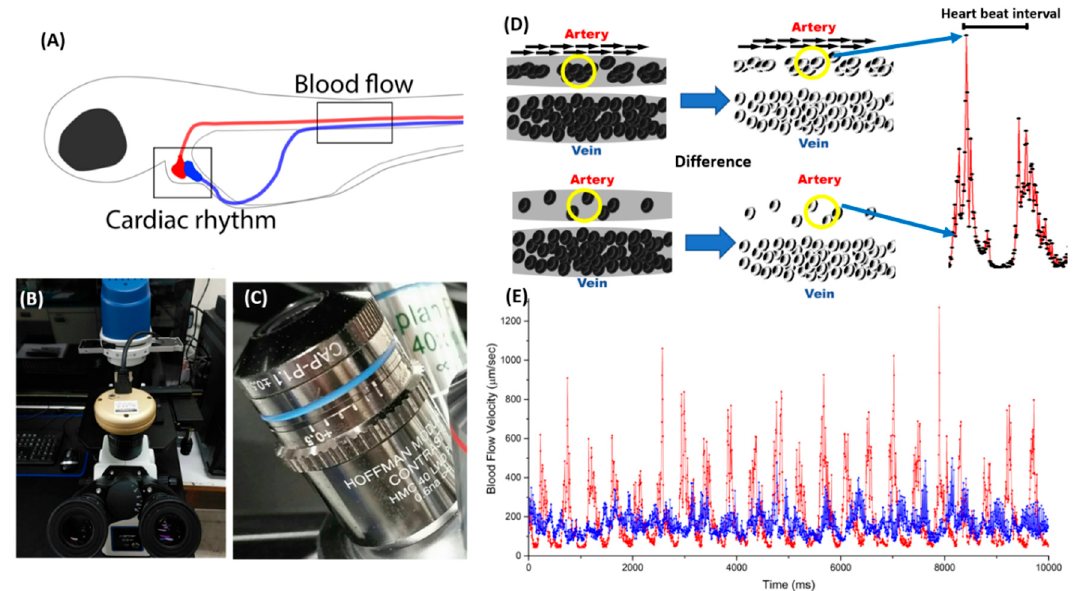
Figure 2. The instrumental framework for blood flow measurement in zebrafish embryos. ( A ) The area to detect heartbeat and blood flow is highlighted in black. ( B ) The inverted microscope, high-speed CCD and ( C ) Hoffman objective lens was used to record blood flow. ( D ) The dynamic pixel changes in the selected region-of-interest (ROI) of the artery or vein were calculated. ( E ) The typical velocity pattern for both artery (red color) and vein (blue color) were obtained using dynamic pixel change methodology.